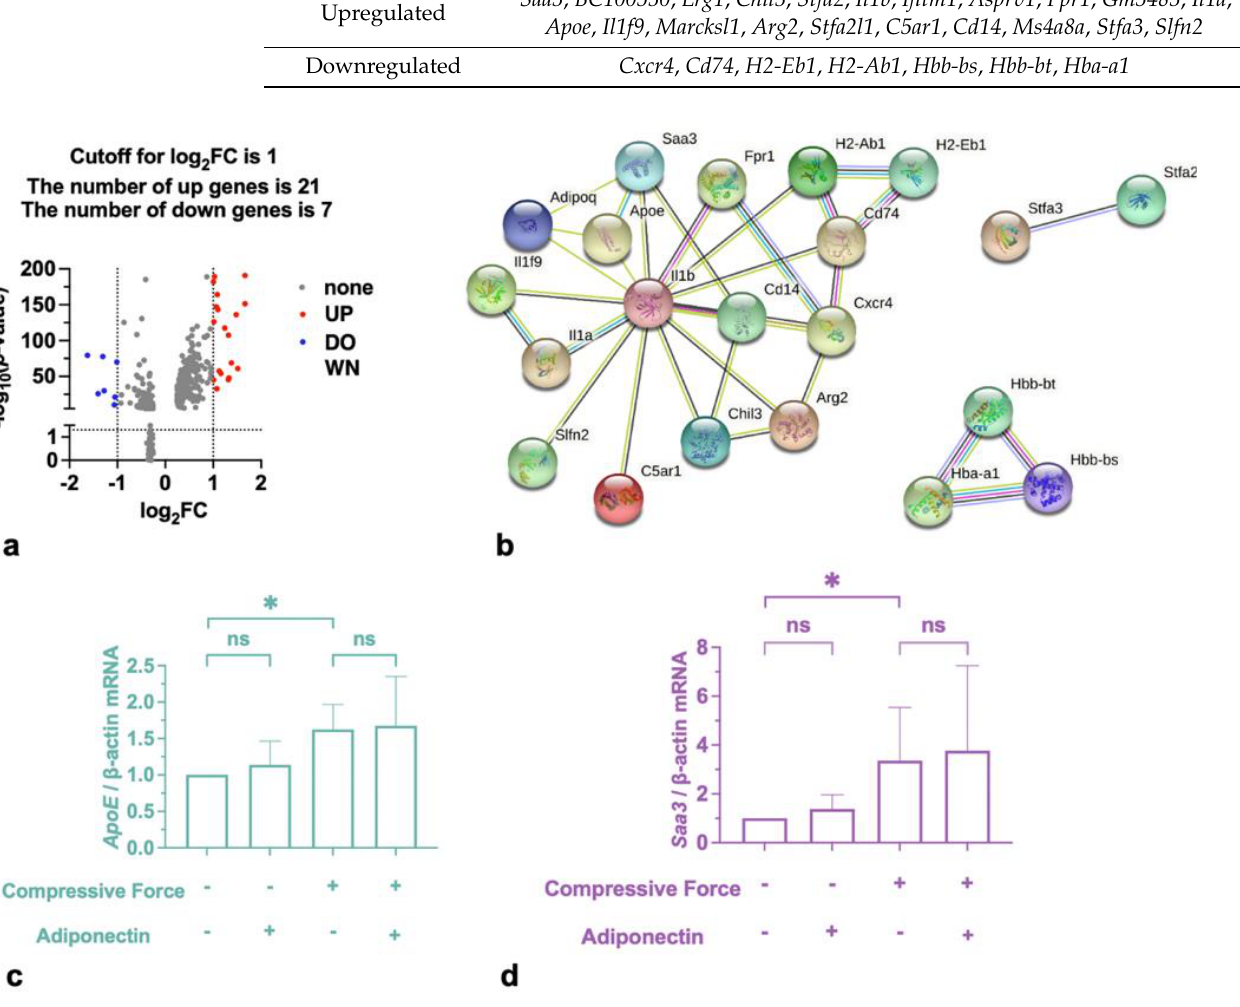
Figure 3. Compression modulates adiponectin-related genes. ( a ) Volcano plot illustrates significant differences in gene expressions pattern between macrophages with and without stimulation by compressive force. ( b ) Based on the STRING online database, top 21 upregulated or downregulated differential genes and adiponectin were filtered into the DEGs PPI network. ( c , d ) Increased mRNA expression of Saa3 and ApoE was detected by qRT-PCR. Values are expressed as means ± SD; ns—not significant; * p < 0.05.